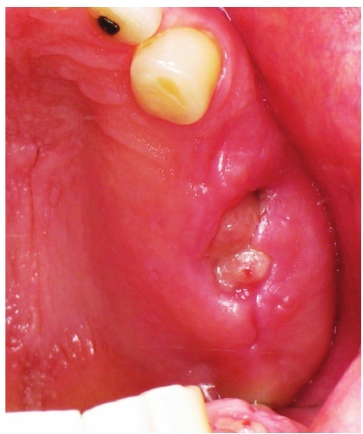
Figure 6: Extraction site healing 1 week after tooth removal (note the visibility of the L-PRF membrane).